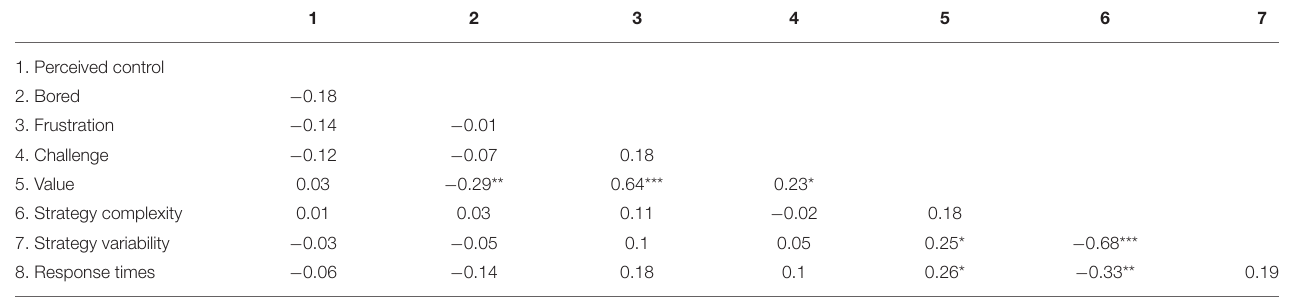
TABLE 2C | Zero-order correlations of all study variables in the Low Perceived Control condition and their significance levels. 1 2